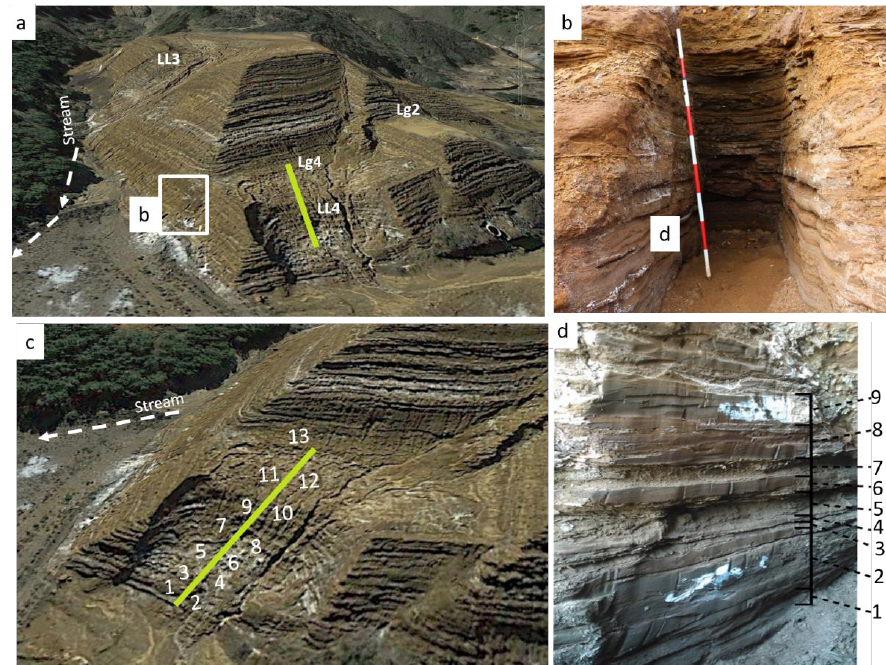
Figure 4. ( a ) El Descargador tailings dam, ( b ) trial pit excavated in the East wall, ( c ) sampling points of sand dikes exposed on the surface of the landslide four (LL4), ( d ) detail sedimentary layer and sampling points by different layer in vertical profile. The white color indicates the precipitation of the different types of sulphates that contribute to the cementation of the tailings in the dam. The discontinuous arrow indicates the direction of the stream runoff.